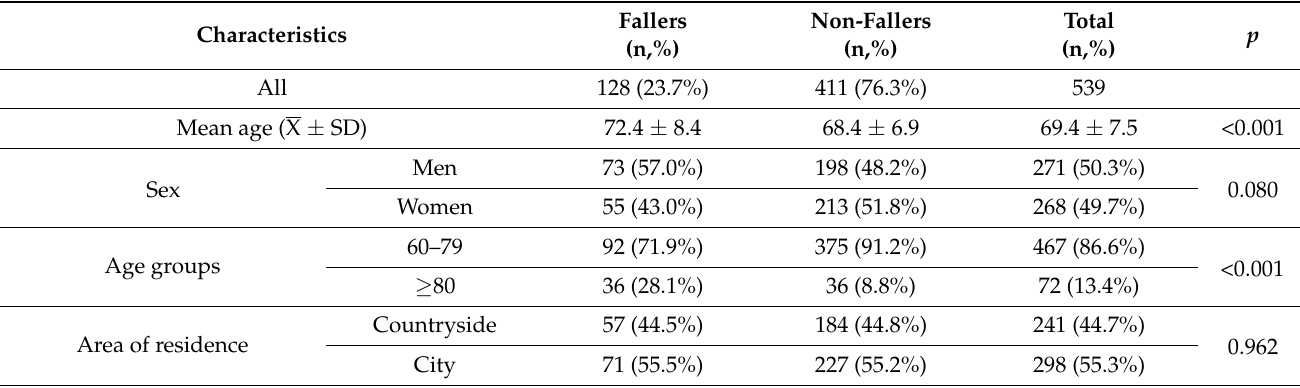
Table 1. Participant general